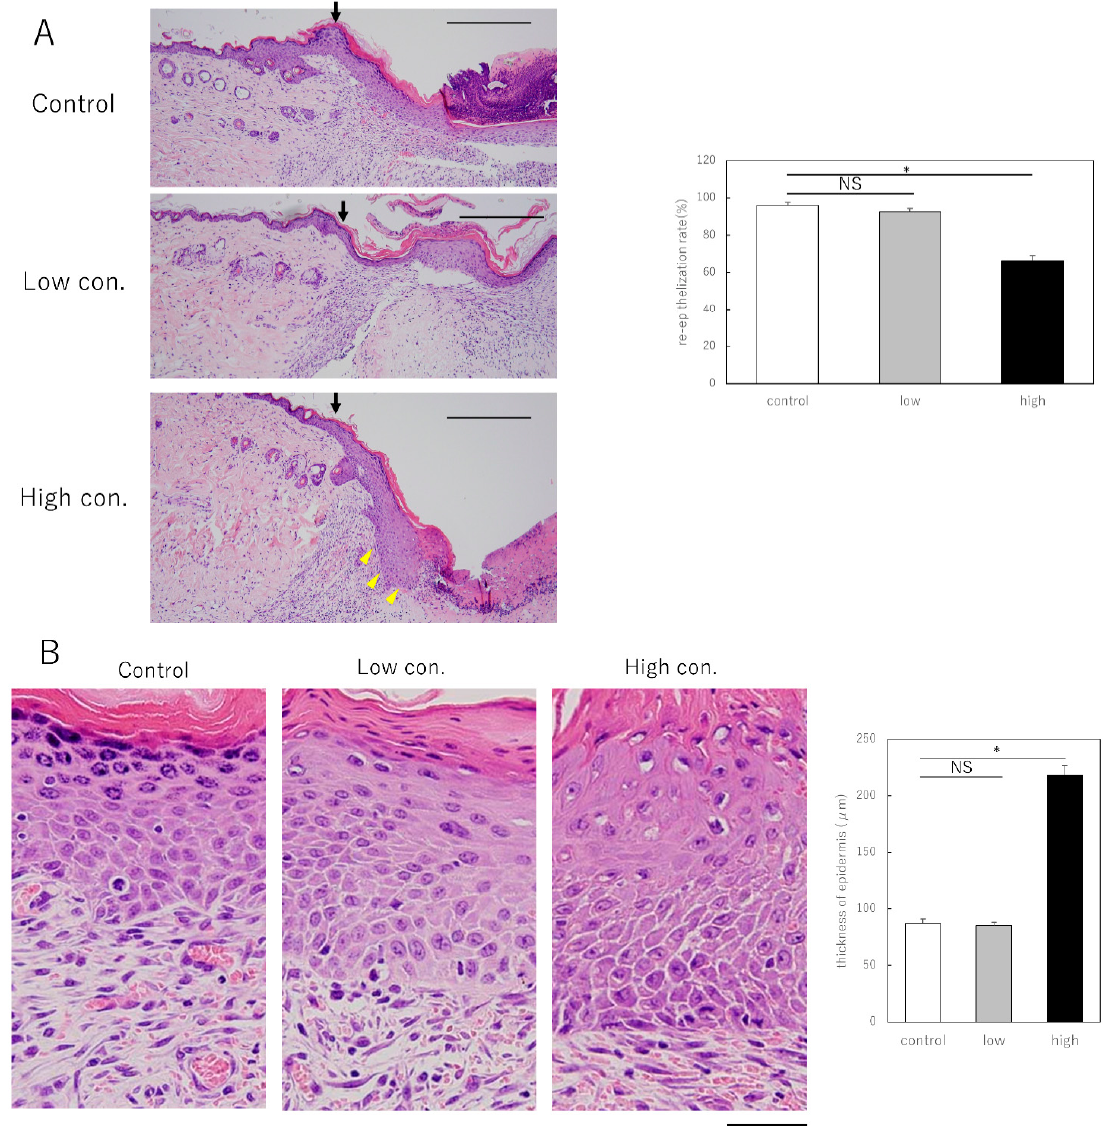
Figure 2. Effect of cyclopamine administration on wounds from adult mice. ( A ) Comparison of epithelialization rate after cyclopamine administration. Black arrows indicate the boundaries of the scar. Yellow arrows indicate thickened epidermis. Bar = 100 μ m. * p < 0.05. ( B ) Comparison of epidermal thickness in the scar area after cyclopamine administration. Bar = 20 µ m. * p < 0.05. NS; not significant. Cyclopamine at concentrations of at least 50 μ g/ μ L caused prolonged epithelialization and epidermal thickening in adult mouse wounds.